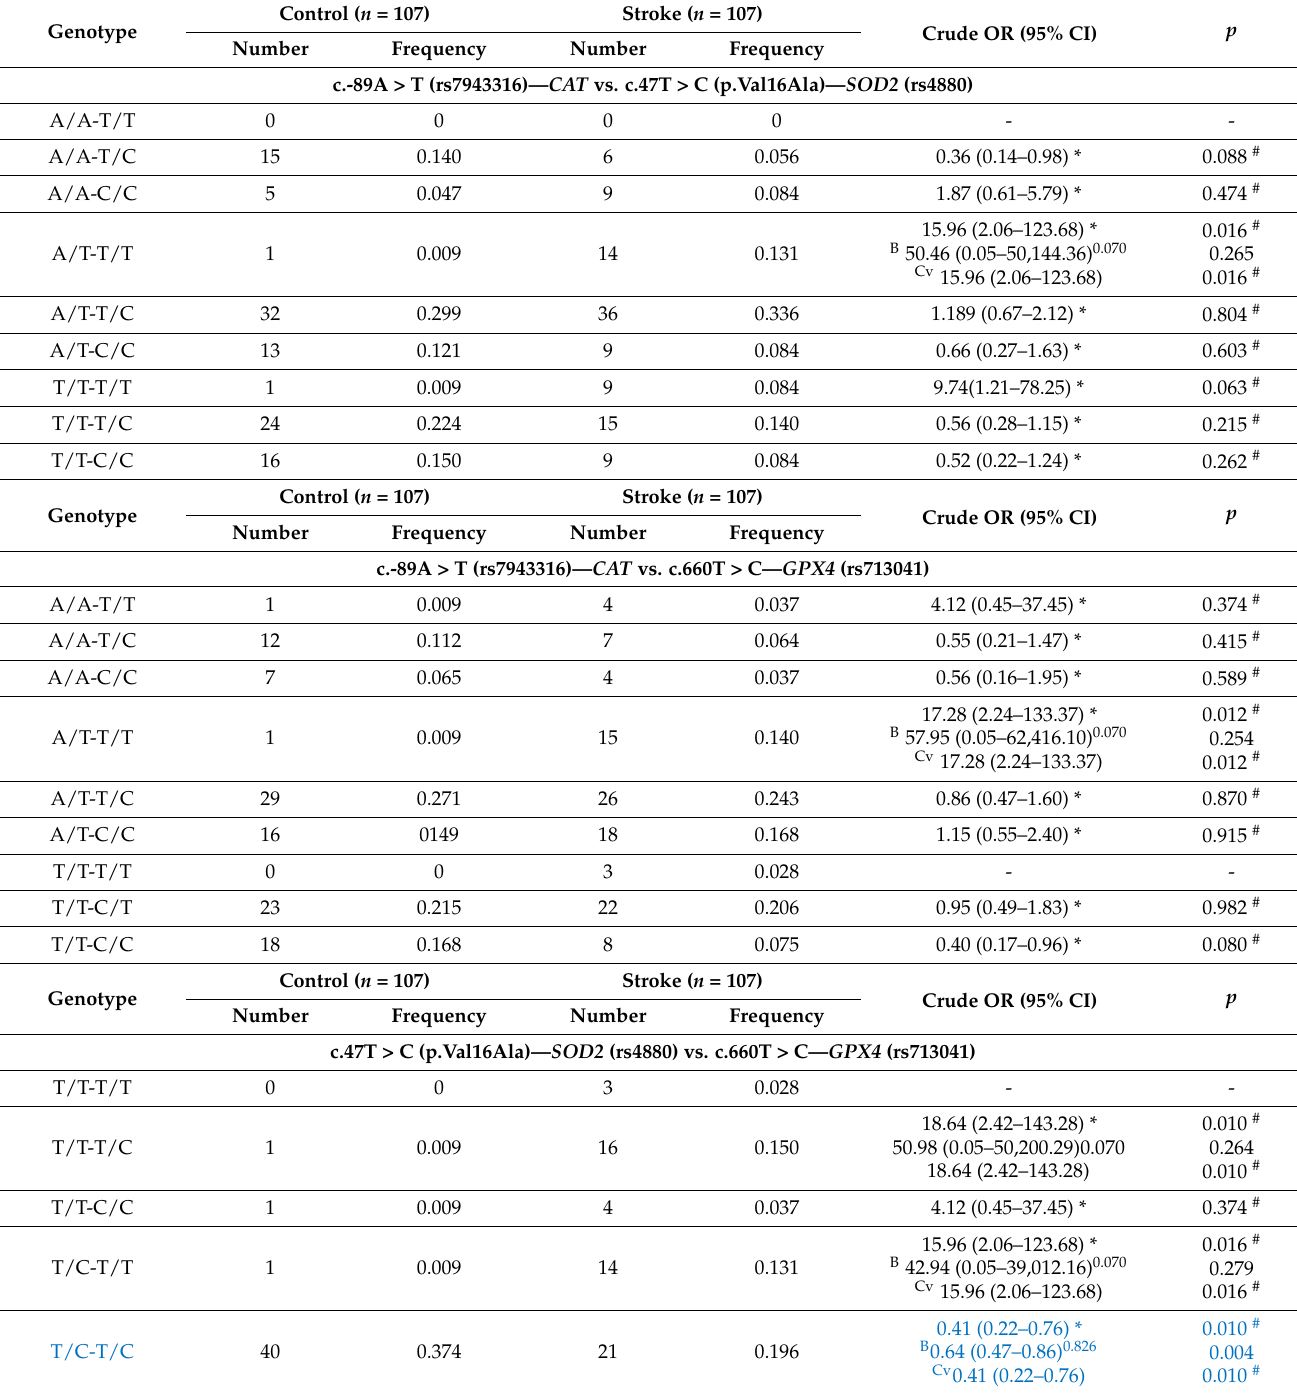
Table 8. Distribution of combined genotypes of the c.47T > C (rs4880) in the SOD2 gene, c.-89A > T (rs7943316) in the CAT gene, c.660T > A (rs713041) in the GPX4 gene, g.117803515C > T (rs1879417) in the NOS1 gene, c.1823C > T (rs2297518) and c.-227G > C (rs10459953) in the NOS2 gene polymorphisms and odds ratios (ORs) with 95% confidence intervals (95% CIs) in patients with stroke and